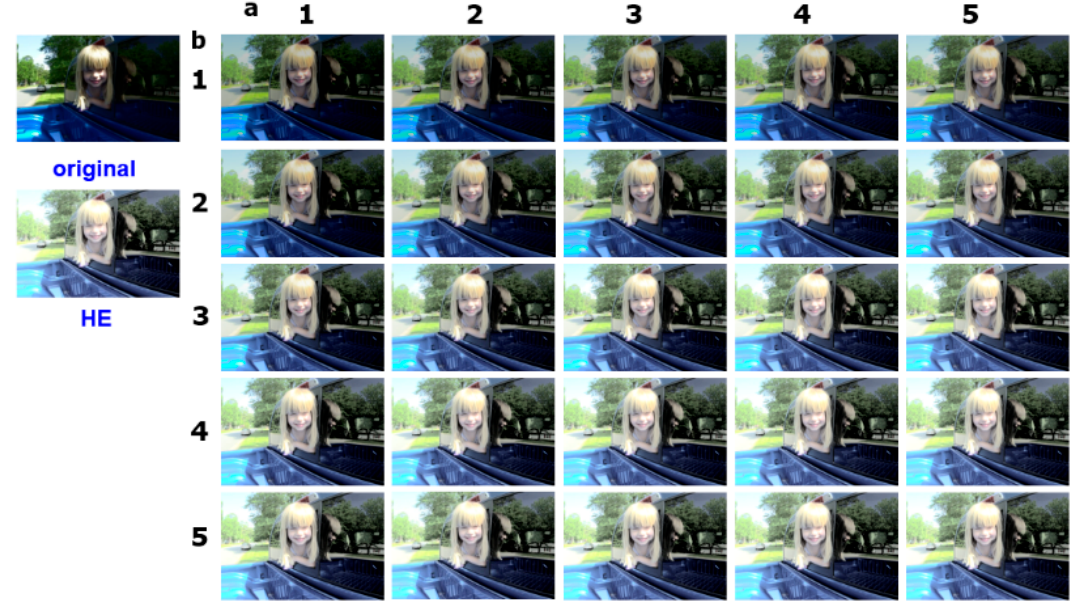
Figure A2. Image, Girl [29], processed by GA with different a and b .